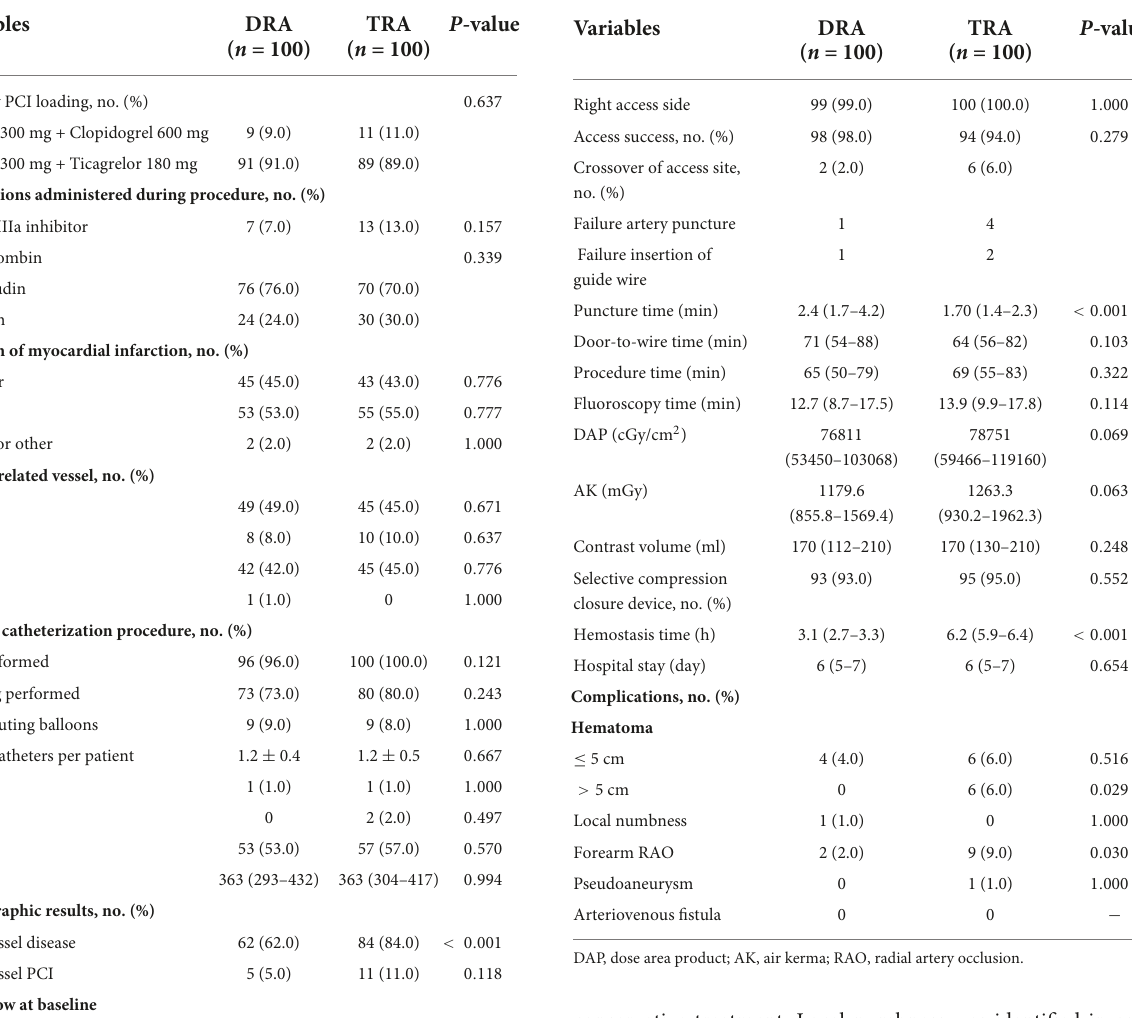
TABLE 2 Procedural characteristics and outcomes. TABLE 3 Primary and secondary